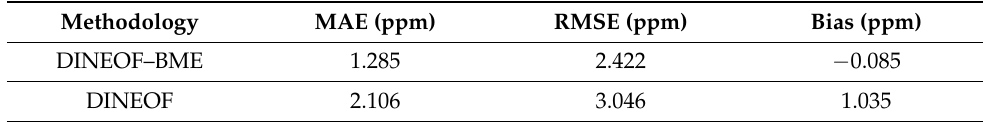
Table 1. The Result of 5-Fold Cross Validation.